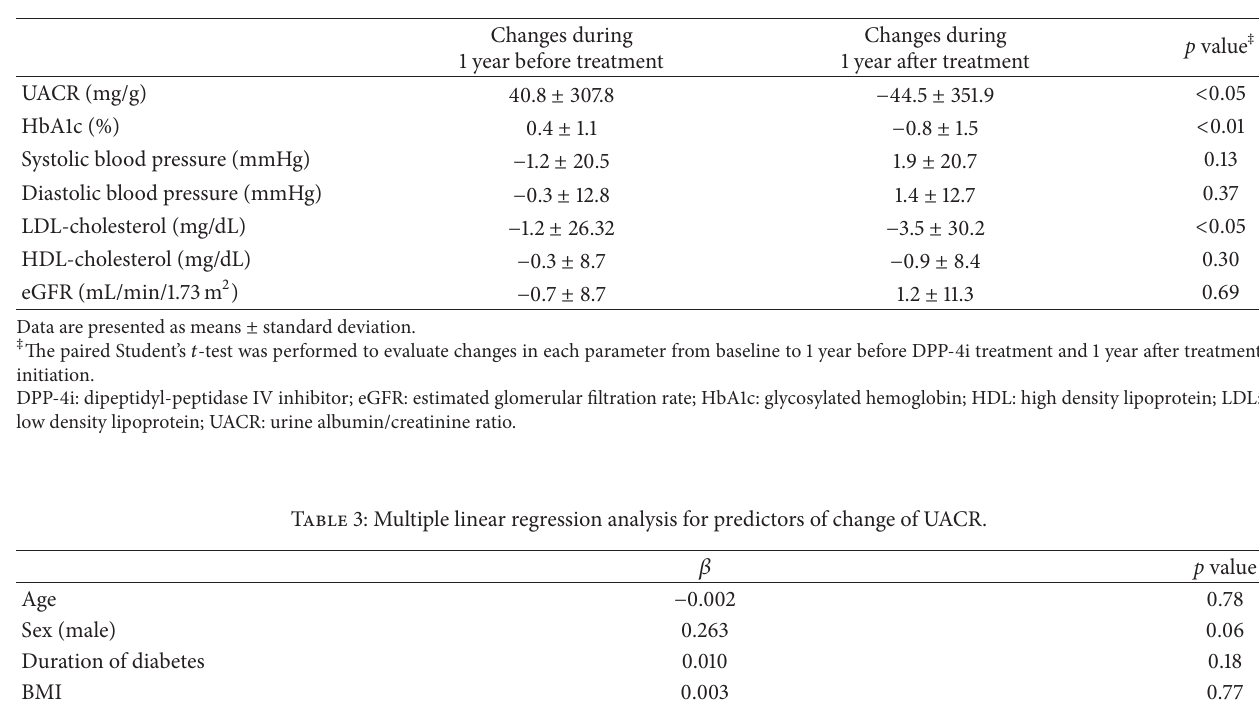
Table 2: Changes in UACR, HbA1c, eGFR, and lipid profiles 1 year before and 1 year after DPP-4i treatment initiation.